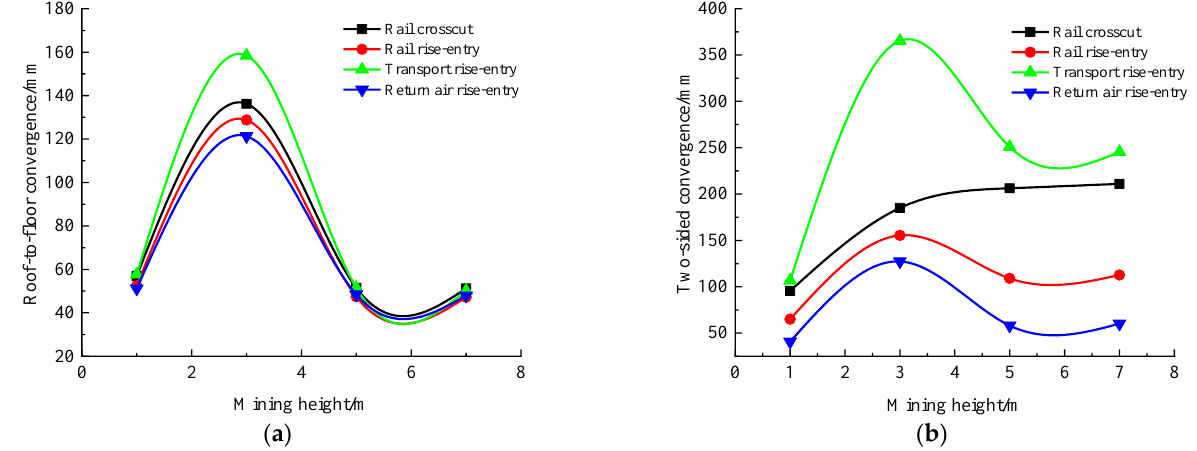
Figure 12. Monitoring results of convergence in roadway-concentrated areas under different mining height conditions. ( a ) Roof-to-floor convergence, ( b ) Two-sided convergence.